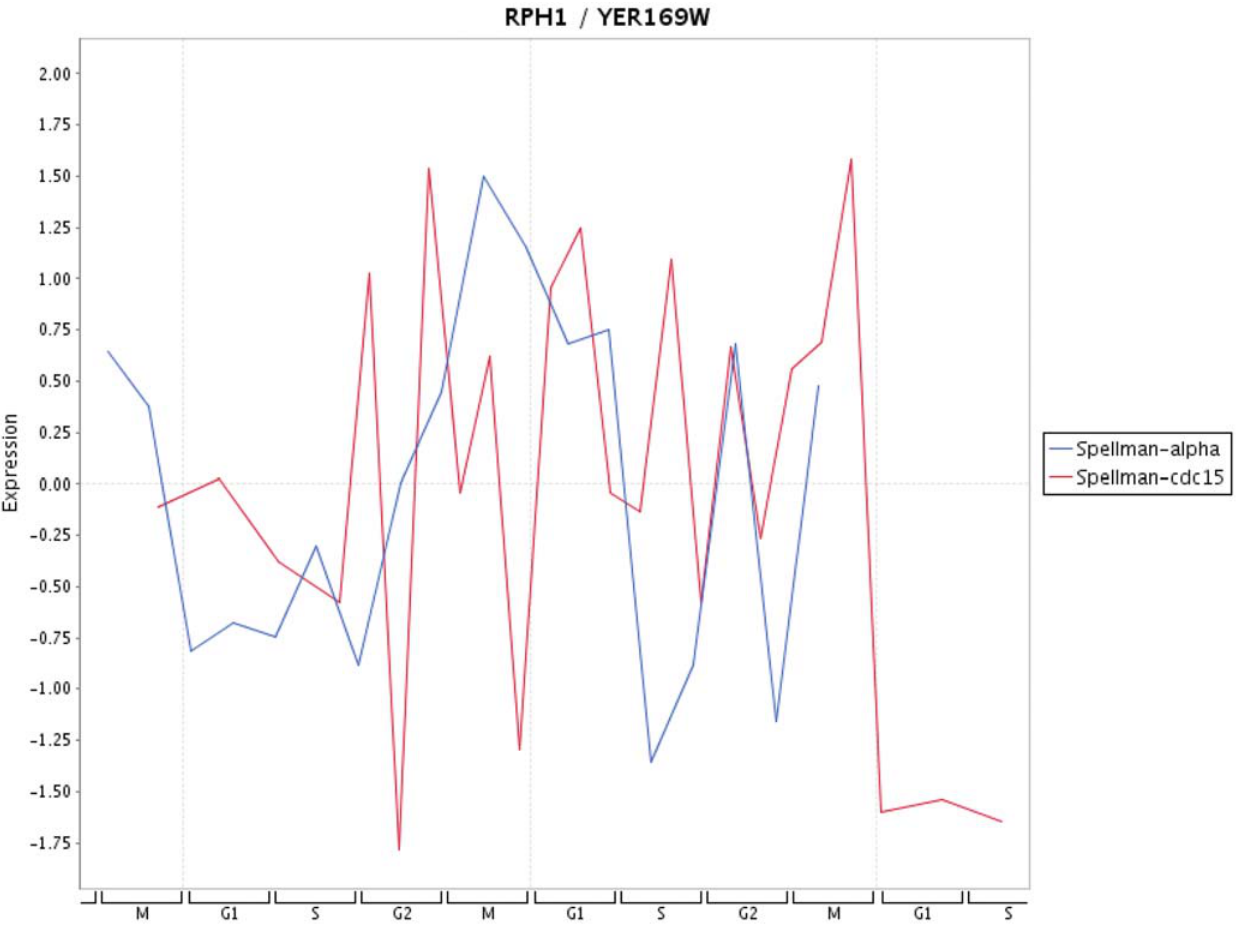
Figure 10. Expression profile for RPH1 for time series data from S PELLMAN et al. [ 32 ] .